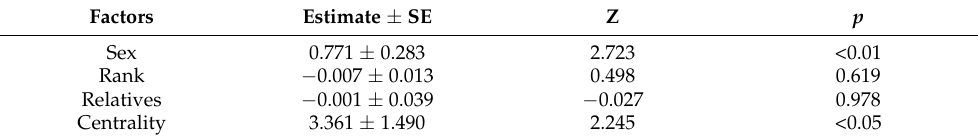
Figure 4. Eigenvector centrality coefficients for group members within the social network. Nodes indicate individuals; females and males are marked in orange and blue, respectively; the labels indicate the name of an individual; the size of the node indicates the value of eigenvector centrality; the thickness of links indicates the degree of proximity relations; the pair of numbers in the bracket represents social rank and number of relatives, respectively. Table 5. Social factors influencing the vocal frequency tested using GLMM.